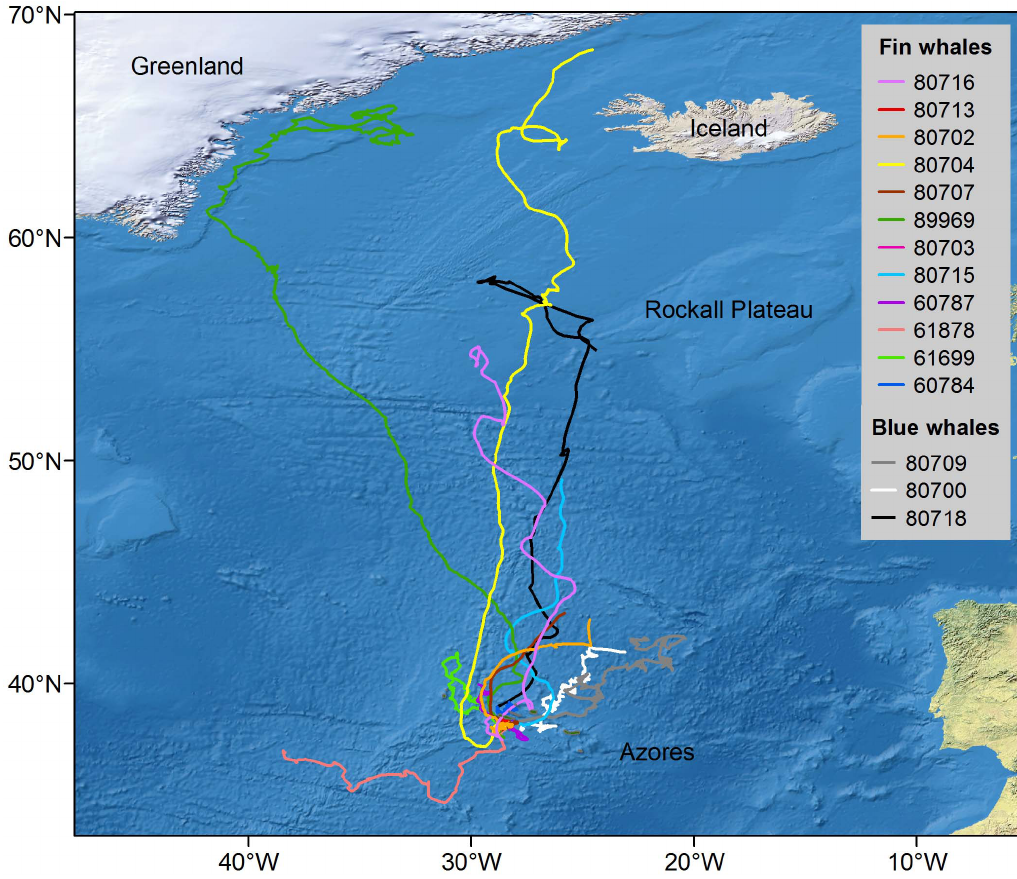
Figure 1. Hierarchical switching state-space model derived tracks of 12 fin whales and 3 blue whales.